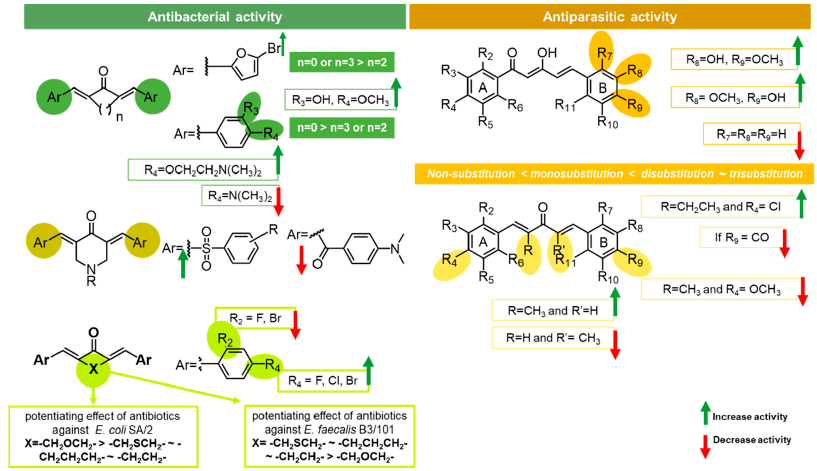
Figure 4. Putative SAR for the anti-infectious activity of diarylpentanoids.